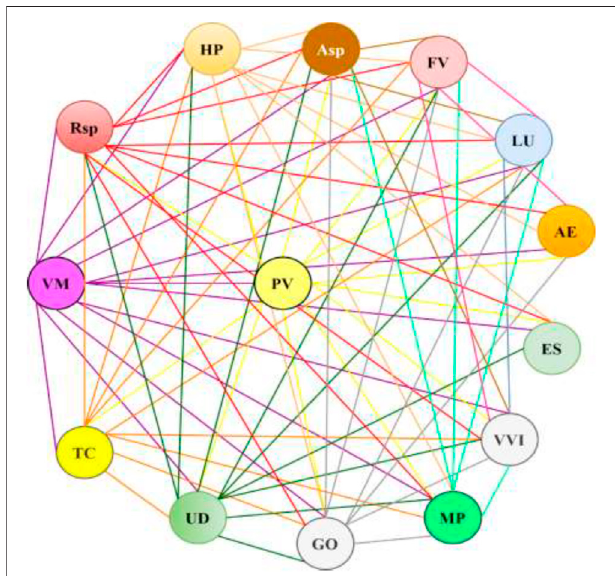
FIGURE 3 | The combinations of the medicinal plants with a high probability of antidiabetic effects in medical species. The plant abbreviations are presented in Table 4